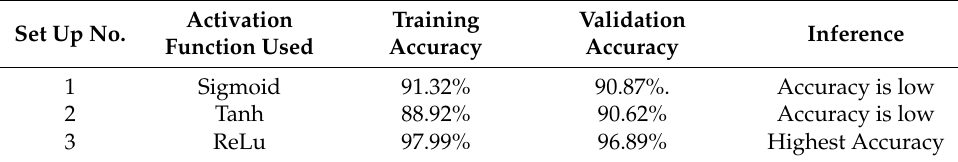
Table 11. Results of ablation study 2, adjusting the activation function. Set Up No.